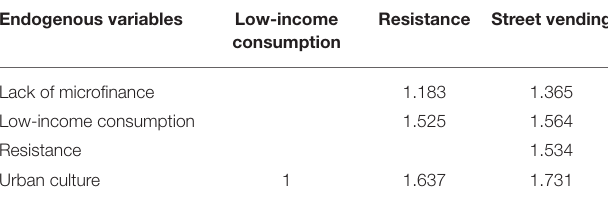
TABLE 4 | Variance inflation factors (VIF) as an indicator of